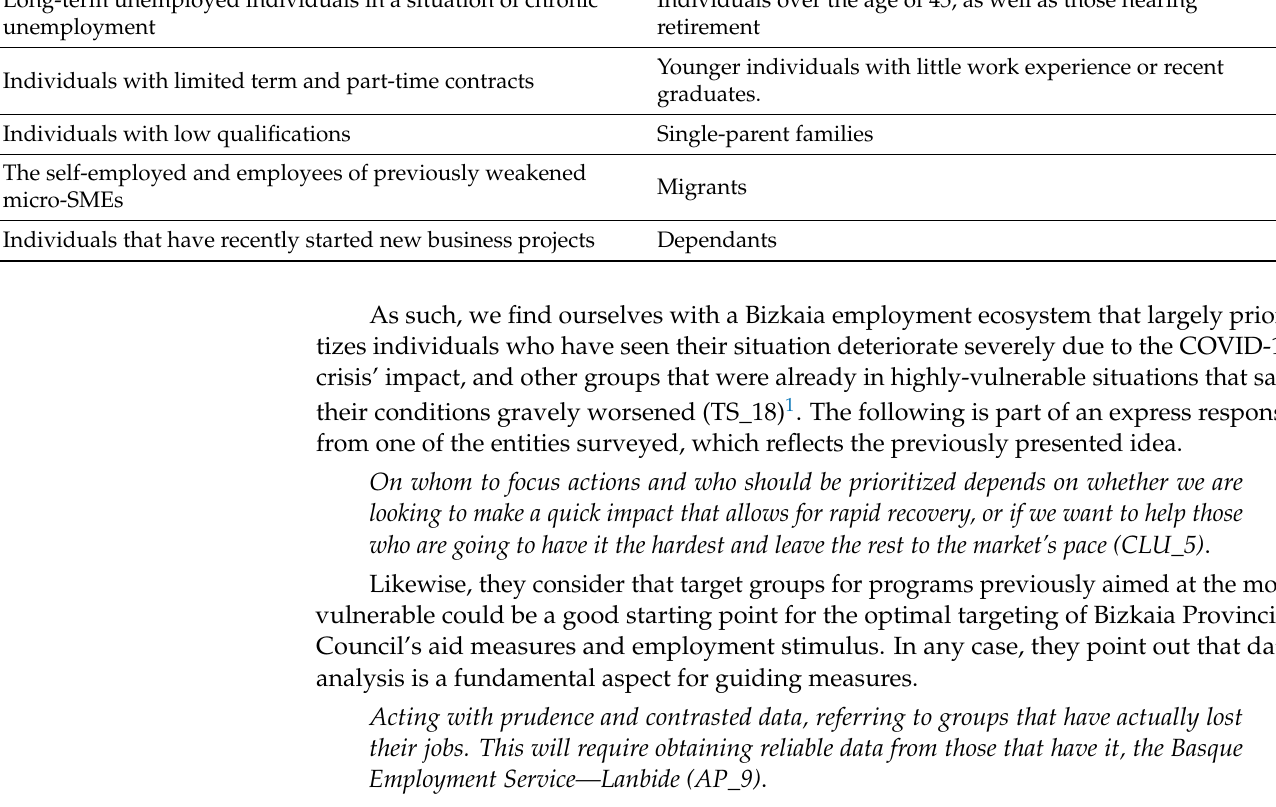
Cross-Cutting Conditions That Intensify Vulnerability Women, particularly domestic workers and caretakers Individuals over the age of 45, as well as those nearing retirement Younger individuals with little work experience or recent